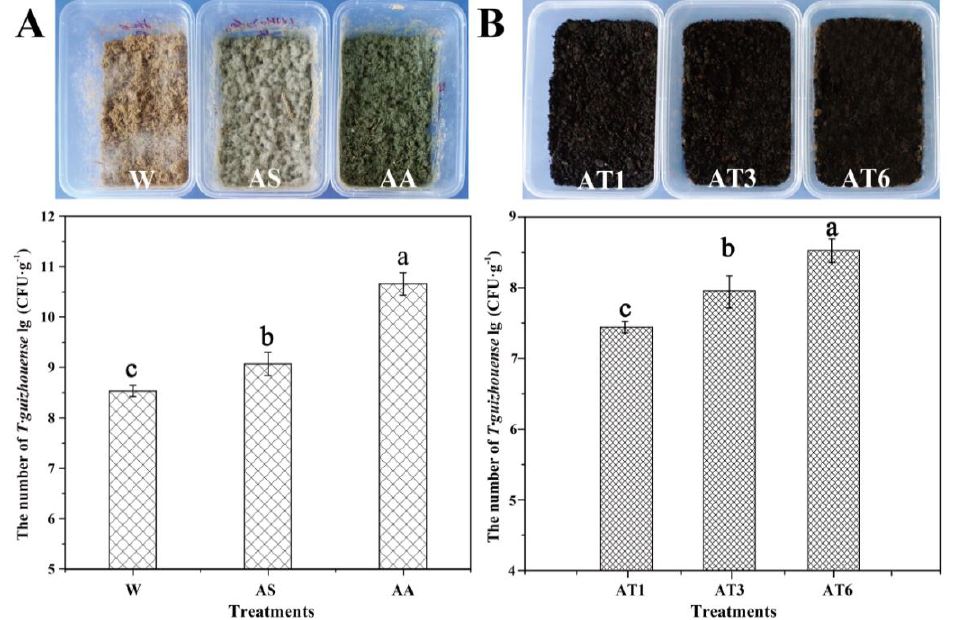
Figure 1. Preparation of Trichoderma guizhouense NJAU4742 solid spawn ( A ) and NJAU4742-based biological organic fertilizer ( B ). W means sterile water, AS indicates ammonium sulfate, AA is the treatment fortified with amino acid solution; AT1: 20% (v/w, dw) amino acid solution and 1% (w/w, dw) biological organic fertilizer (BOF) (w/w, dw); AT3: 20% (v/w, dw) amino acid solution and 3% (w/w, dw) BOF; AT6: 20% (v/w, dw) amino acid solution and 6% (w/w, dw) BOF. Data are repressed as means ± SDs of 3 replicates. Values with different letters in the same column are significantly different at p ≤ 0.05 according to Duncan’s ANOVA test.